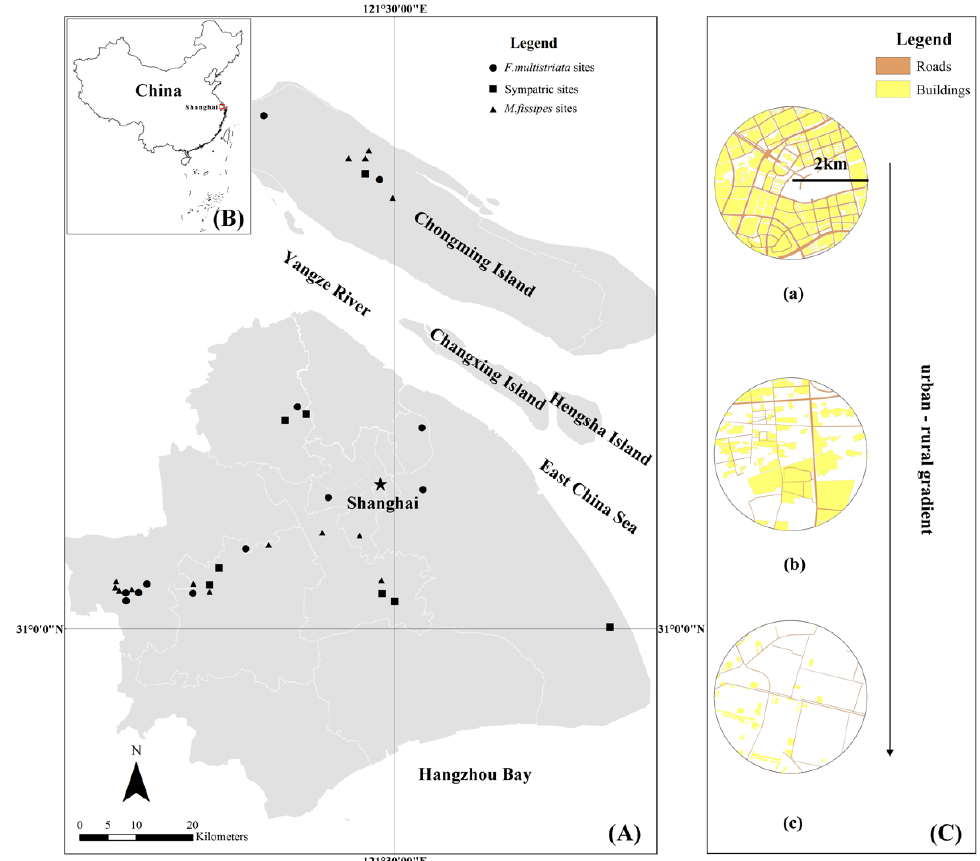
Figure 1. Locations of the 34 study sites along an urban–rural gradient in Shanghai ( A ), China ( B ). In total, 22 and 20 study sites were used for M. fissipes and F. multistriata , respectively, with eight sympatric sites. Three examples of study sites within a 2 km radius of different UI sites along an urban–rural gradient in Shanghai ( a : 0.812; b : 0.469; c : 0.042) ( C